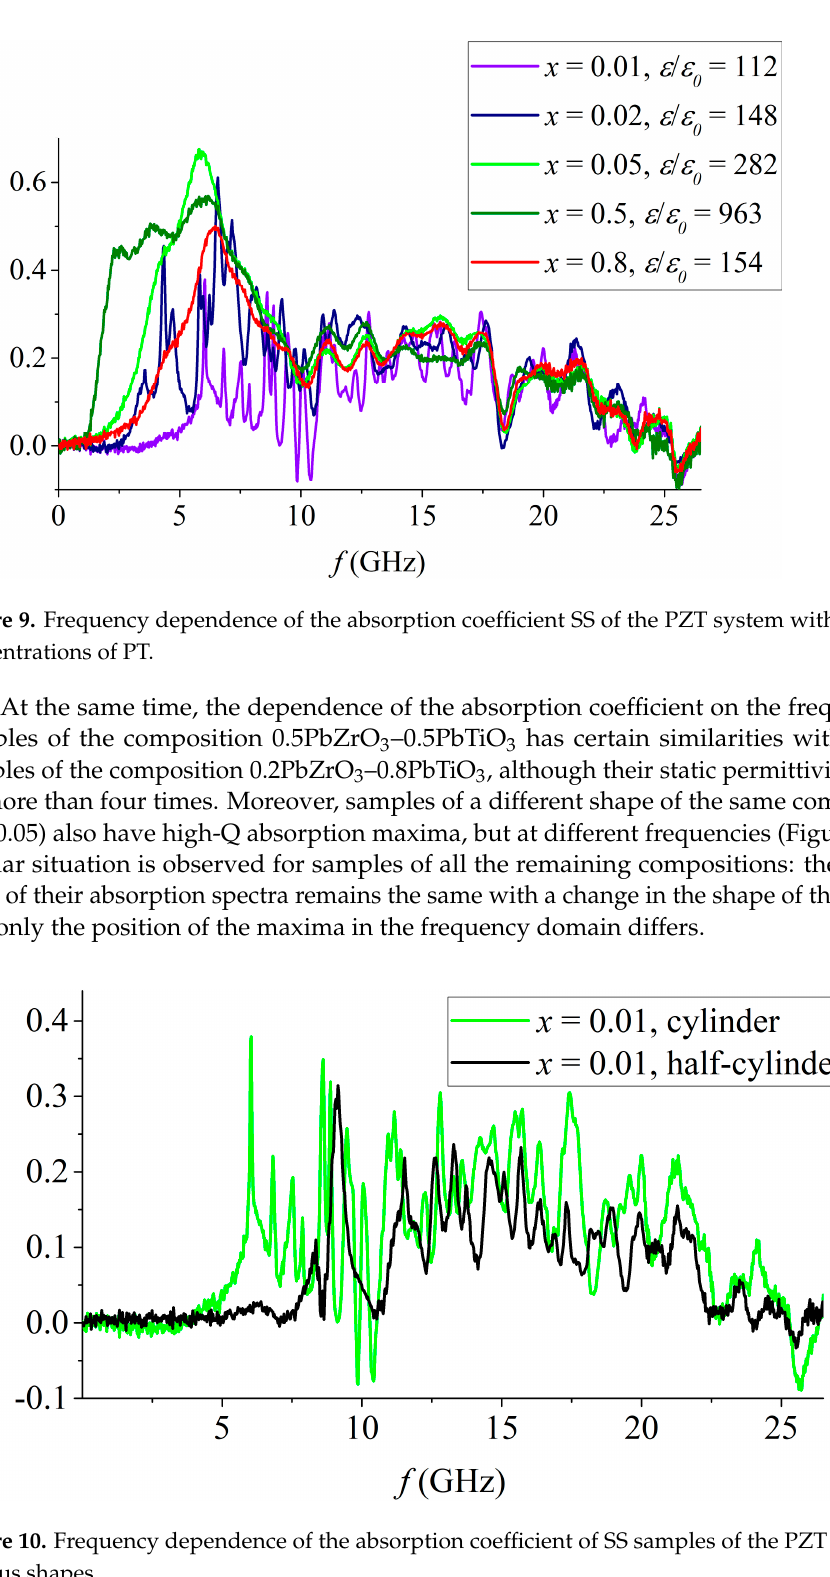
SS samples. The color is chosen for contrast, and to make this 3D pattern easier to associate with 2D